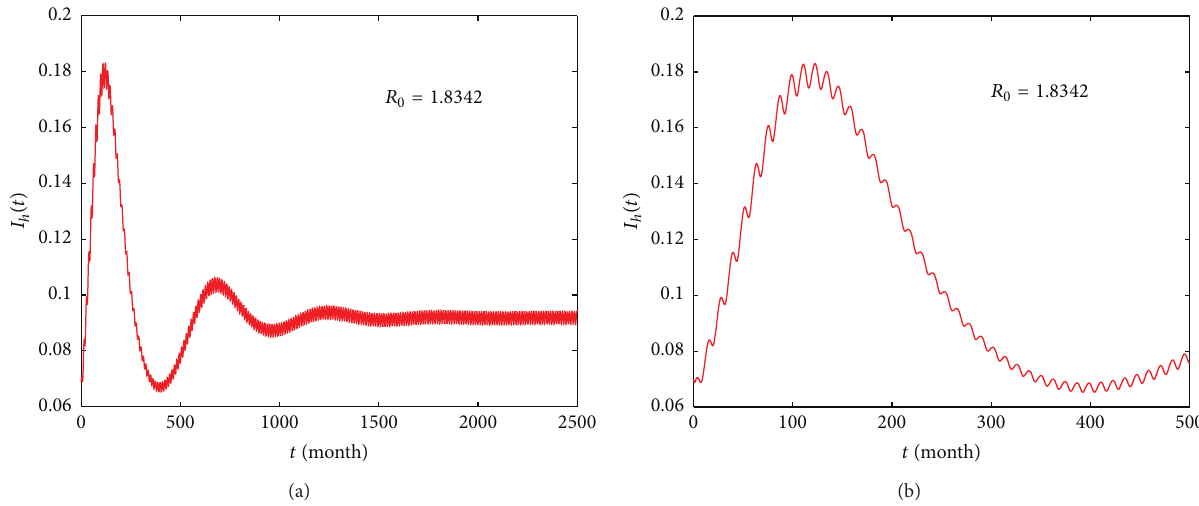
Figure 3: The figures show that the infected citrus population is permanence. (a) 𝑡 ∈ [0, 2500] ; (b) 𝑡 ∈ [0,500] .